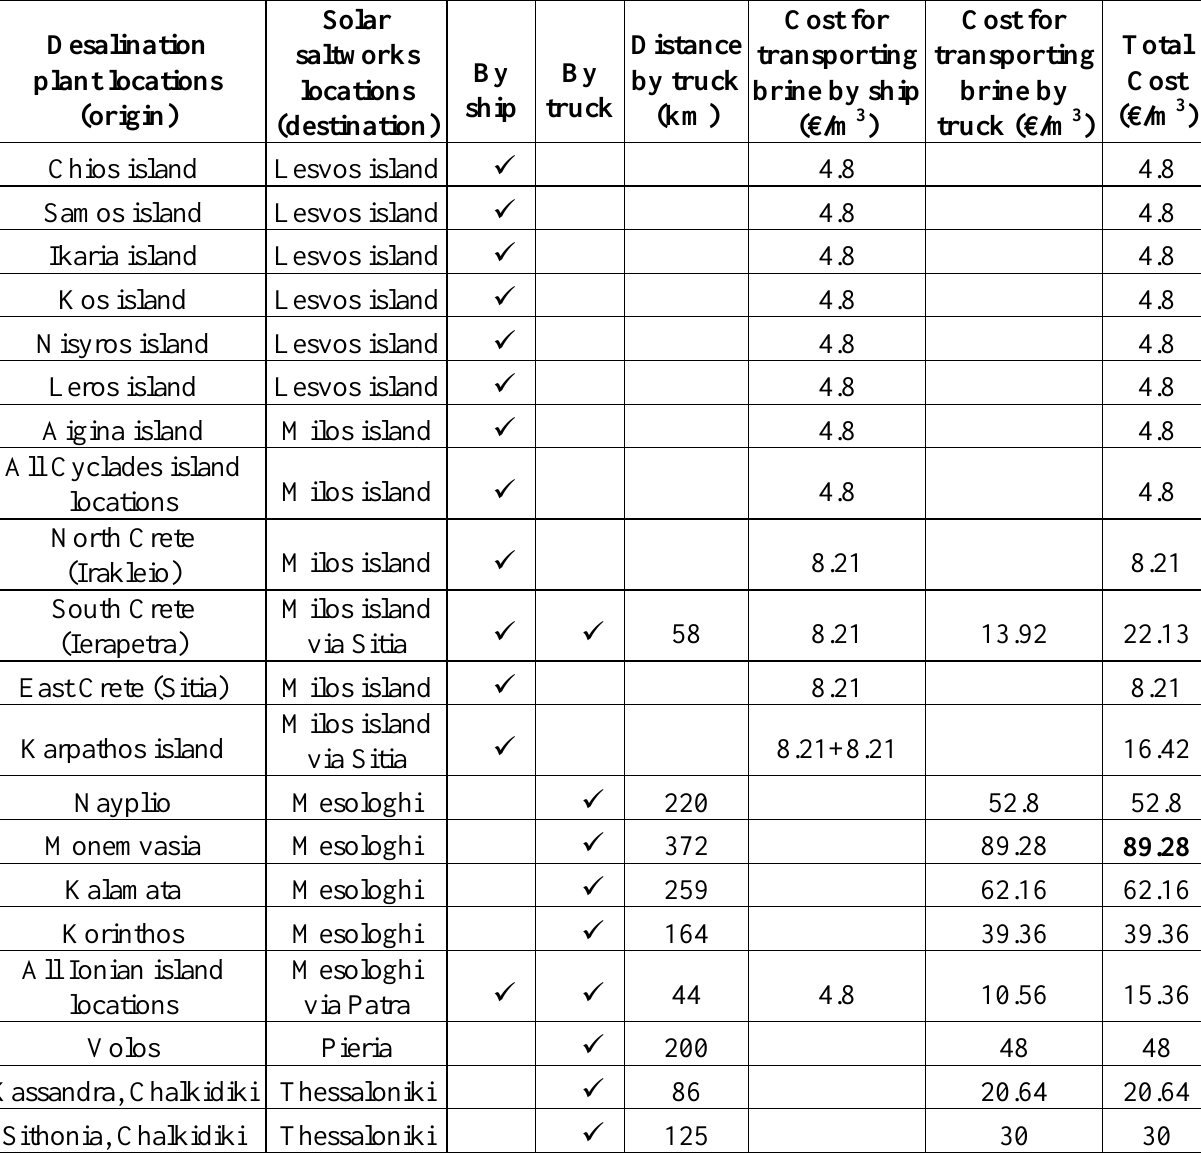
Table 2. Routes and costs of transporting brine from desalination units to solar